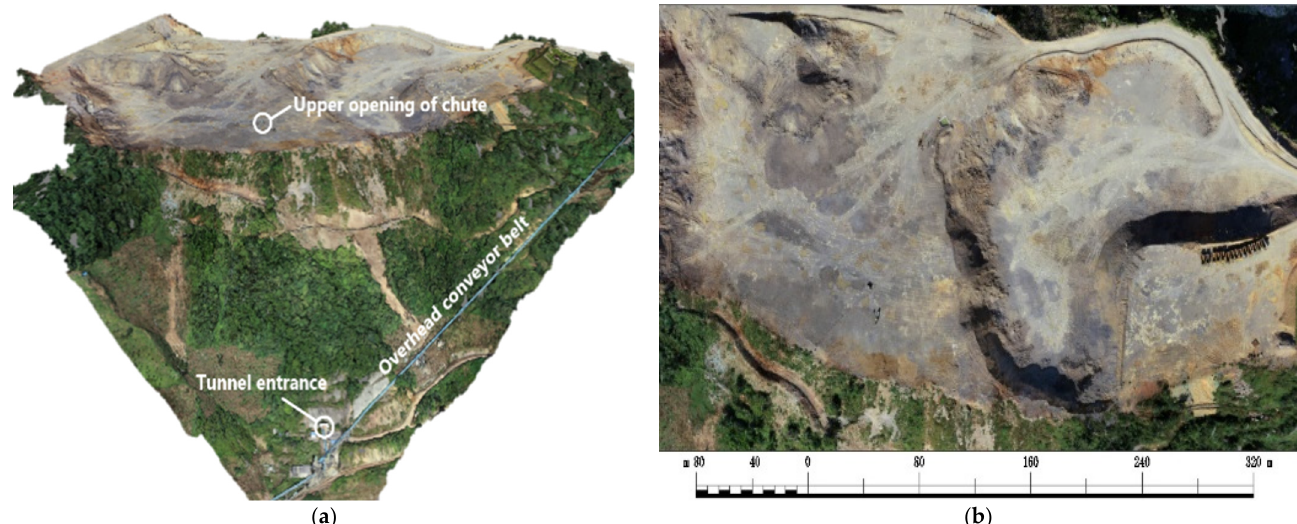
Figure 3. Overview of the study area. (The model is constructed by tilt photogrammetry.) ( a ) Overall view of the mine; ( b ) Front view of the mining part of the mine.